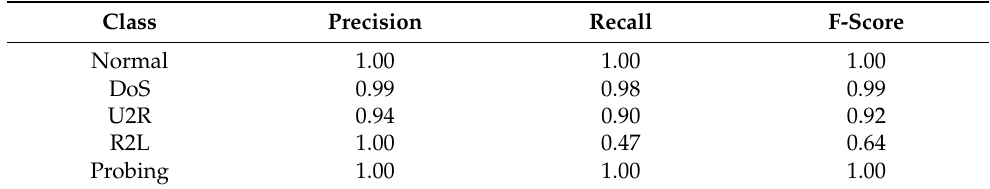
Table 10. Deep ANN-based anomaly detector’s traditional performance metrics recorded (multino- mial classification).